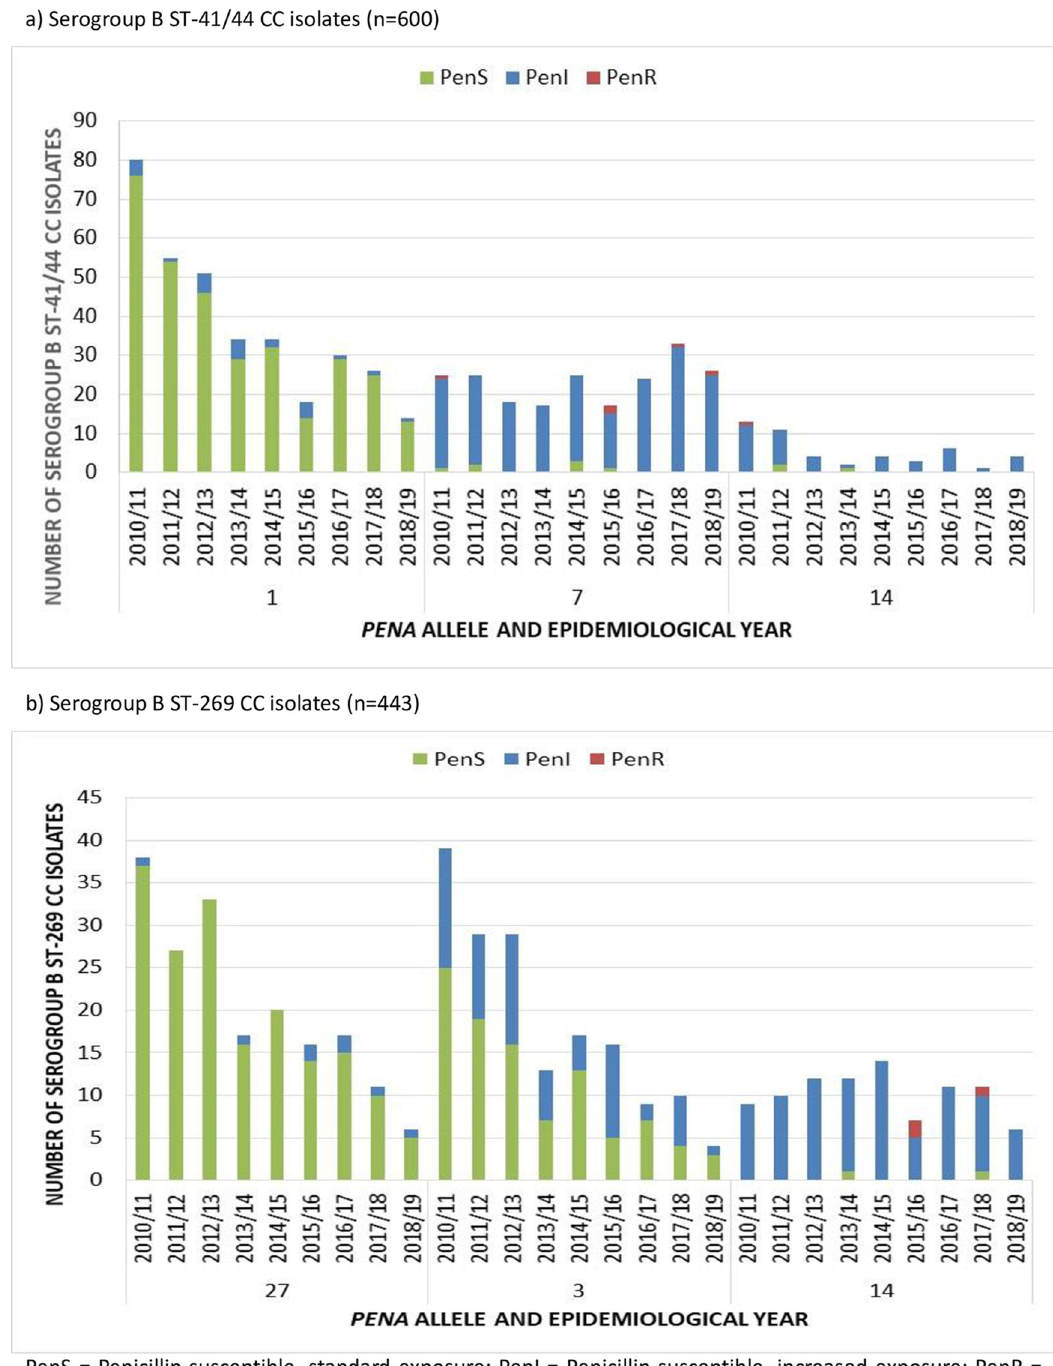
Fig 3. Prevalent penA alleles among serogroup B IMD isolates belonging to ST-41/44 and ST-269 clonal complex in England, Wales and Northern Ireland 2010/11 to 2018/19.